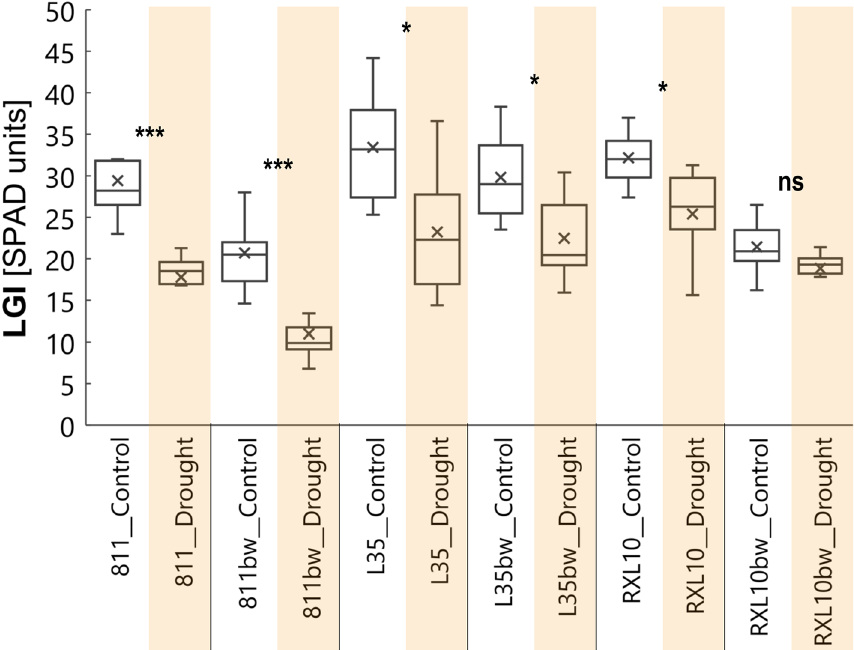
Figure 5. Box plot of leaf greenness index (LGI) by glaucous (811, L35, RXL10) and non-glaucous (811bw, L35bw, RXL10bw) near-isogenic lines of rye and by soil water status (control or drought). The statistically significant differences between the means in control and drought were verified for P ≤ 0.001(***), P ≤ 0.01(**), P ≤ 0.05(*) according to Student’s test. ns not significant.